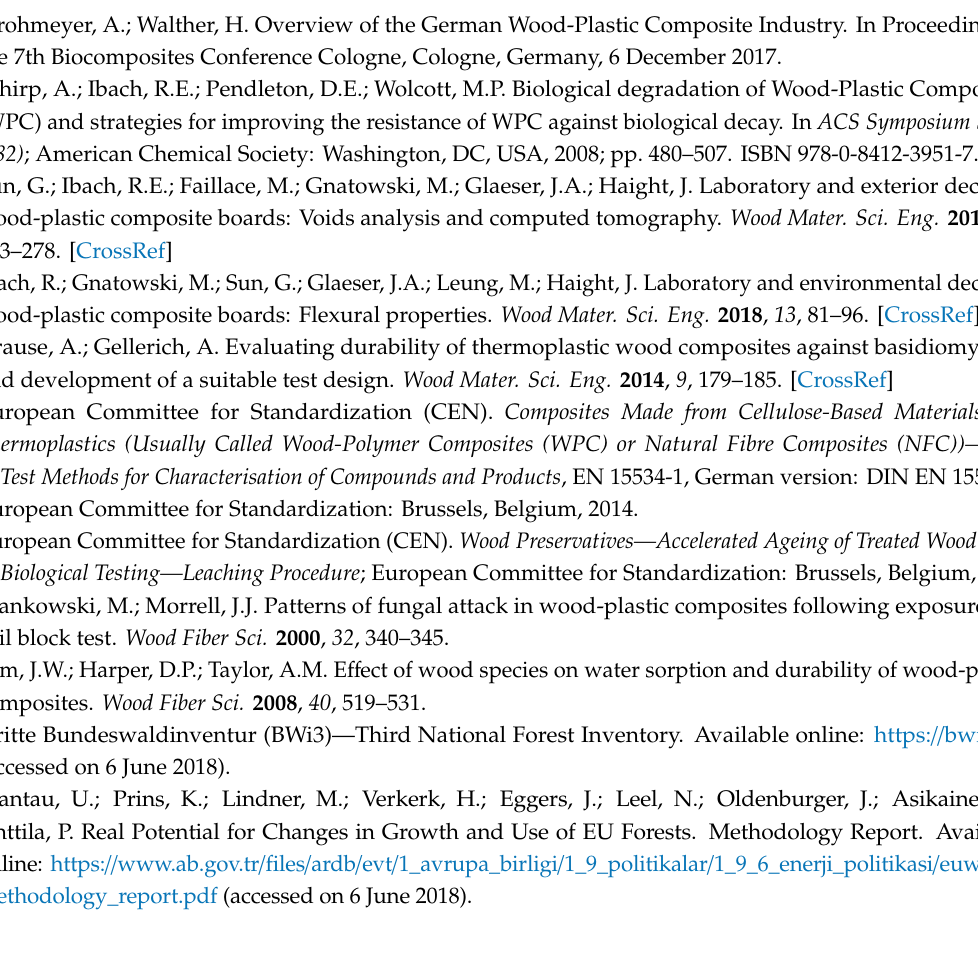
Figure S1: Left: Exemplarily image of sterilized WPC specimens (i.e., S) placed in a kolle flask at the beginning of the degradation procedure. The test fungus (i.e., Trametes versicolor ) is growing towards the WPC specimens. Right: Extracted WPC specimens (i.e., C100 2) covered by fungus mycelium (i.e., Trametes versicolor) after the degradation procedure (i.e., 16 weeks), Table S1: Statistical data of linear correlations between mass loss (ML %) or moisture ( ω %) and modulus of rupture (MOR) and modulus of elasticity (MOE),